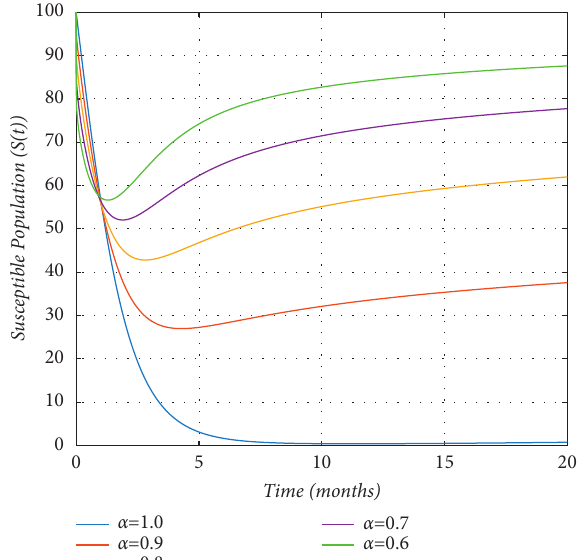
Figure 1: The graph shows the dynamics of the susceptible population ( S ( t )) for different values of the fractional-order parameter ( α ), and the initial population sizes are ( 100 , 90 , 80 , 70 , 60 )